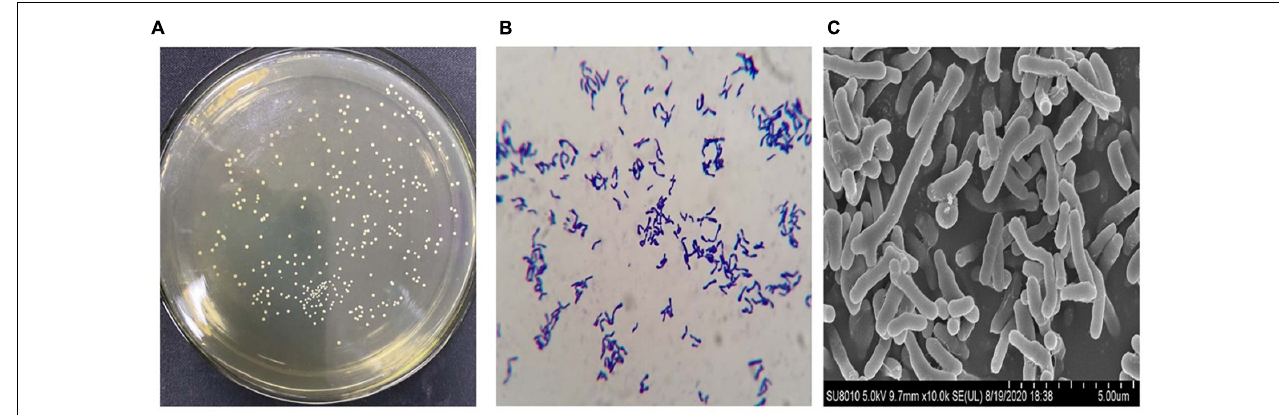
FIGURE 1 | Representative morphologic characteristics of B. longum subsp. longum strains. (A) Colony morphology; (B) Gram staining morphology; (C) Scanning electron microscopy. Morphology of the B. longum subsp. longum strain was obtained using a scanning electron microscope × 10.0 K.